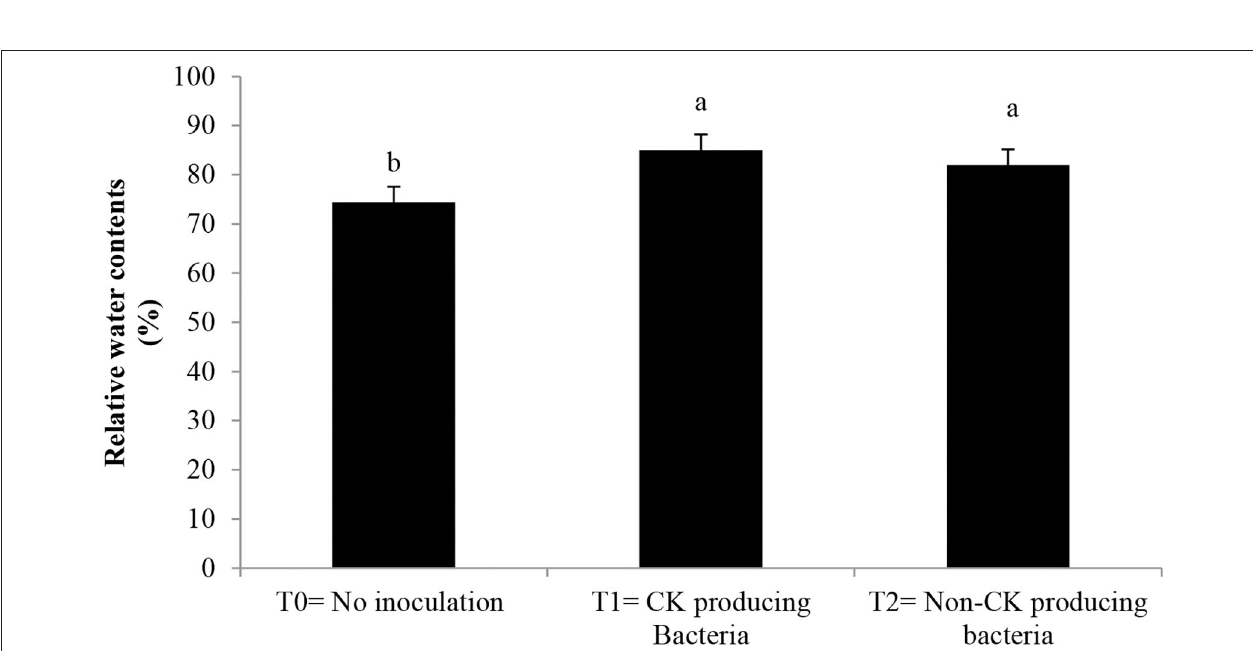
producing strain VS9. However, they found that NAR did not increase due to nitrogen deprivation, which was reversed after the supply of